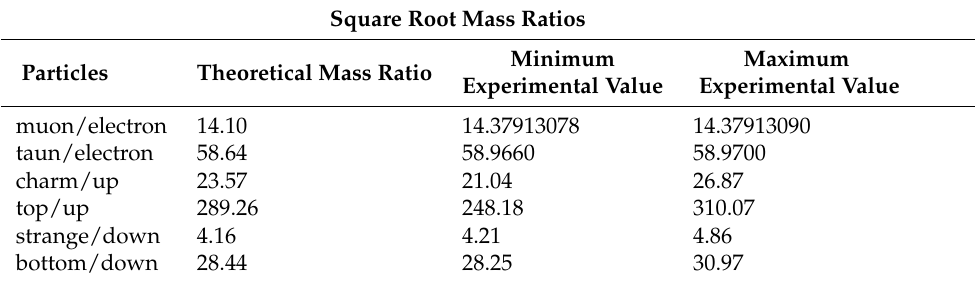
Table 1. Comparison of theoretically predicted square-root mass ratios with experimentally known range